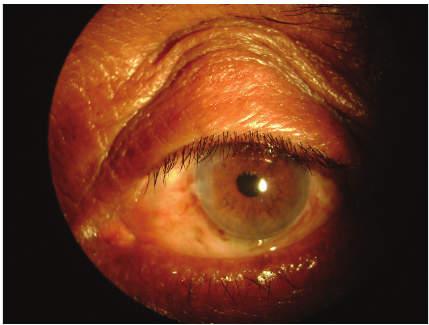
Figure 3: Giant filtration bleb prolapsing through the palpebral aperture in the second